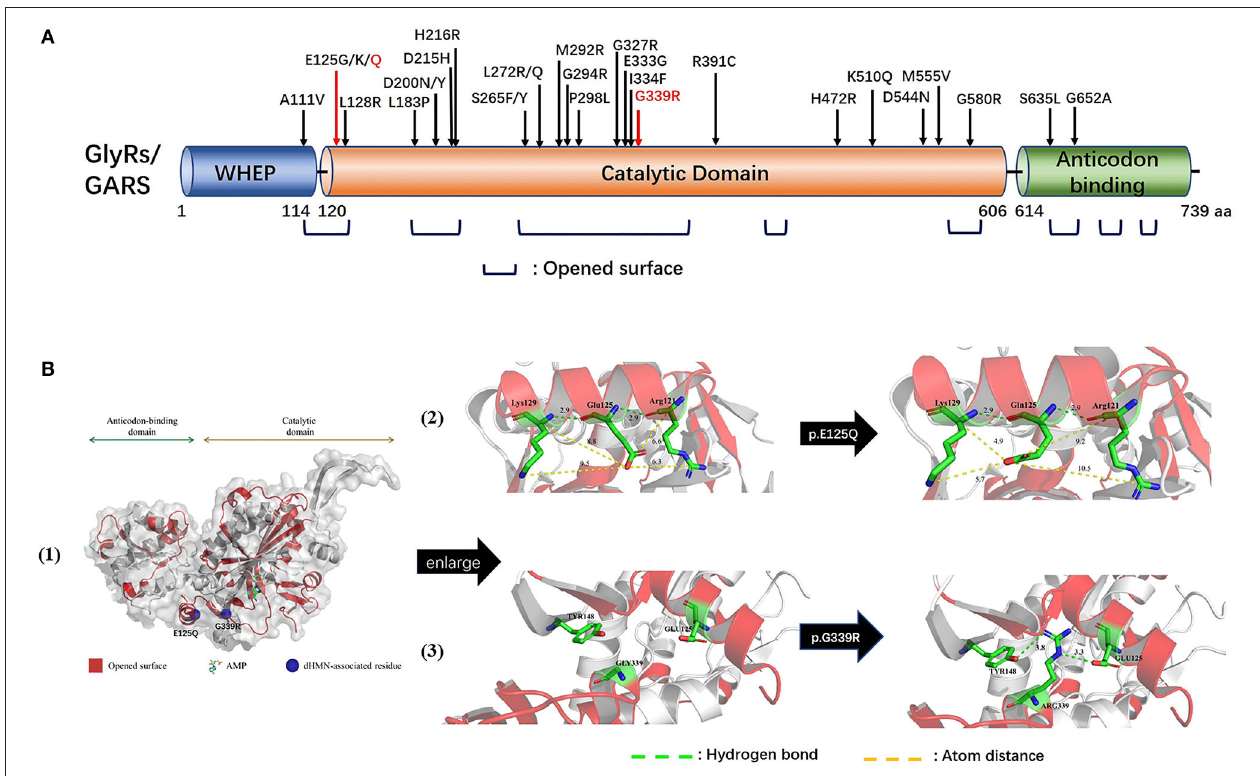
FIGURE 3 | Schematic representation of GARS gene/protein and location of mutations. (A) Distribution CMT2D/dHMN-associated mutations in the three domains of the cytosolic human glycyl-tRNA synthetase (GlyRS). Red: Novel mutations identified with dHMN-V in this study. Most reported GARS mutations are located in the catalytic domain or lie in one of the eight opened surface regions. Amino acid nomenclature based on transcript NM 002047.2(739a.a). (B) Molecular structures of integral type (left), wild type (middle), and mutant type (right) of human GlyRS (PDB ID: 4KR2). Both residues, p.E125 and p.G339, are strictly conserved in opened-up surface area of hGlyRS, among which p.G339 also located within the glycine-binding pocket. The substitution of p.E125Q altered the charge and space resistance with adjacent amino acids. The substitution of p.G339R engendered neomorphic hydrogen bonding interactions between residue p.G339 and